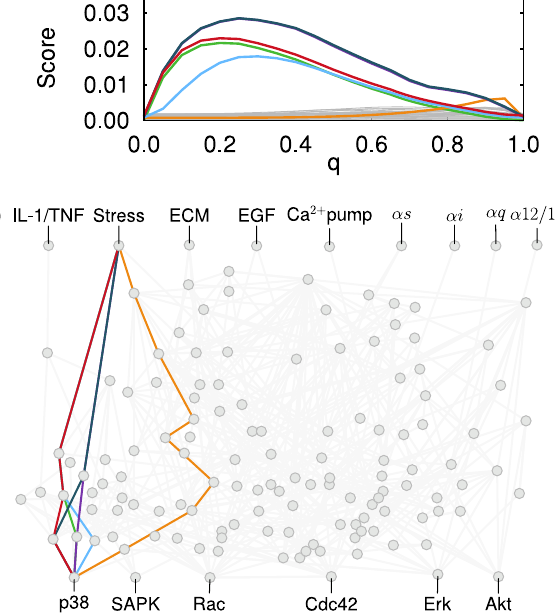
Figure 5. Paths of information flow for varying levels of chatter. (a) Information transmission scores (see text) of the dominant paths versus chatter level for a periodic modulation of the stress input, when considering p38 as output. (b) Edges defining these dominant paths.